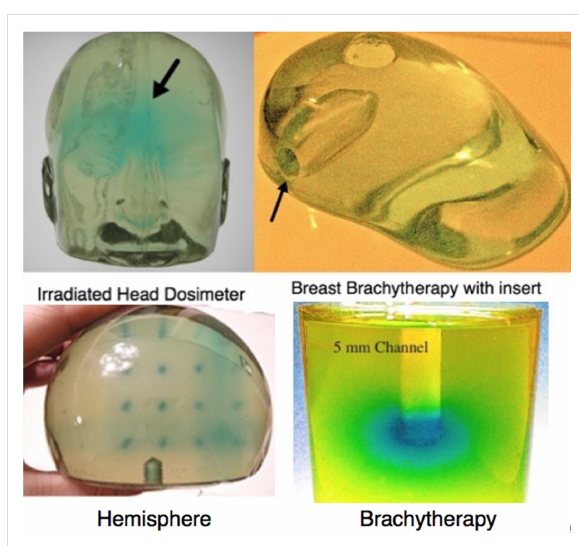
Figure 4: 3D dosimeters fabricated in our lab for a variety of radiation therapies. Top left a head dosimeter (12 kg); on the right a breast dosimeter with an inset for brachytherapy; bottom left an irradiated hemisphere; bottom right a cylindrical brachytherapy dosimeter with 5 mm channel for insert the radiation